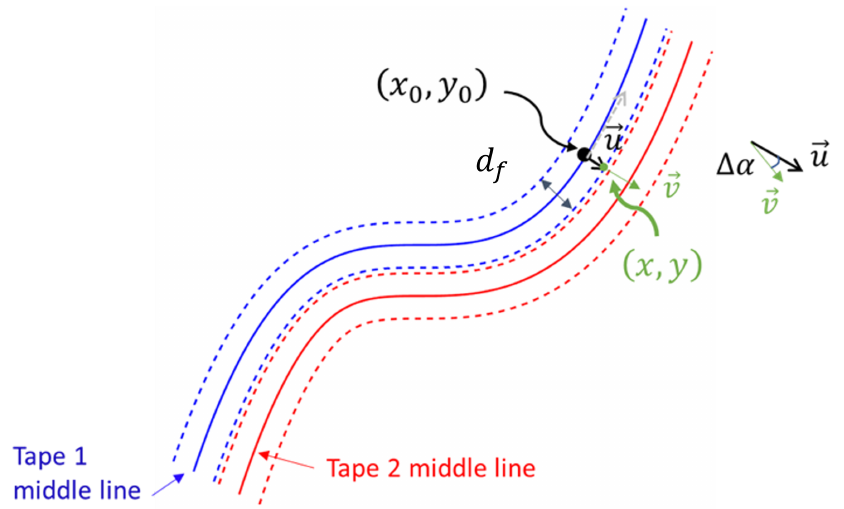
Figure 4. Parameterization of parallelism of two adjacent